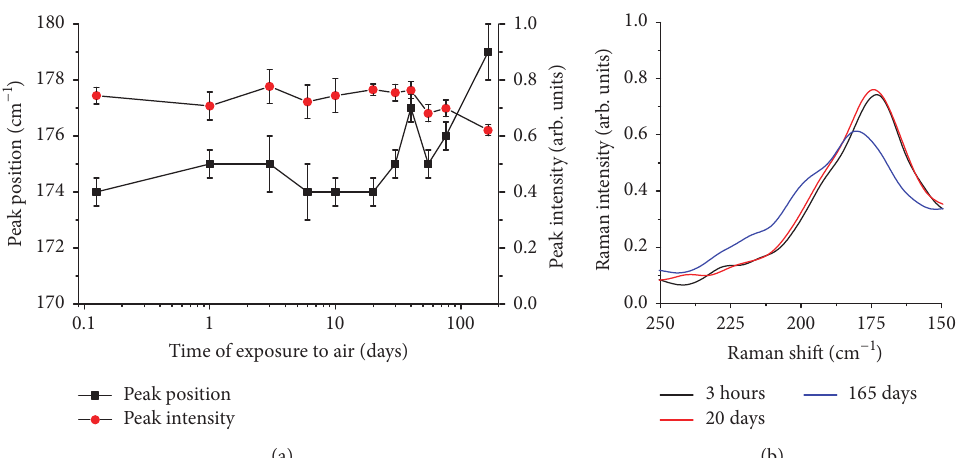
Figure 4: (a) Position (black squares) and intensity (red circles) of the Raman peak at about 174cm −1 for HKUST-1 as a function of time of exposure to air moisture. (b) Raman spectra in the region of the peak at about 174 cm −1 acquired for HKUST-1 after 3 hours, 20 days, and 165 days of exposure to air moisture.